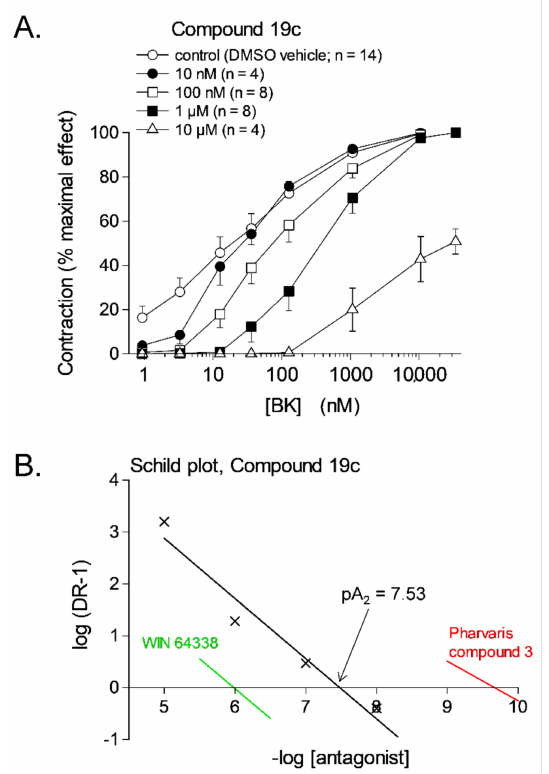
Figure 3. ( A ) Effect of the nonpeptide antagonist of the B 2 R, Compound 19c, on bradykinin (BK)- induced contraction in the human isolated umbilical vein. Each tissue was subjected to the construc- tion of two full cumulative concentration-effect curves, in the absence of antagonist (3 h, not shown) and in the presence of an antagonist or its DMSO vehicle applied 30 min earlier (5 h). Values are the means ± s.e.m. of the number determinations indicated by n . For the highest concentration of the antagonist, the maximal effect of BK was evaluated from the separate curve constructed at 3 h. ( B ) Schild plot analysis for Compounds 19c; the x-axis intercepts of the regressions for 2 other nonpeptide antagonists that span the whole potency range (Table 1) are also shown for comparison. Modified from [45] with